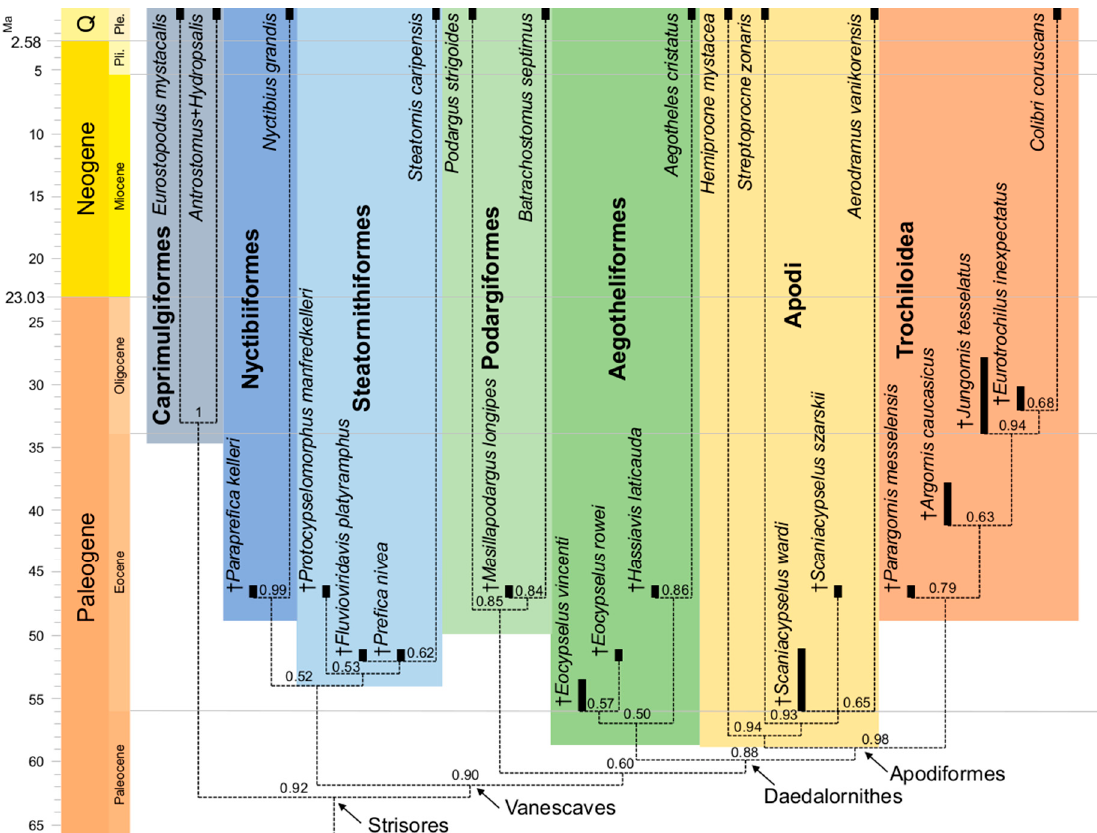
Figure 5. 50% majority-rule tree resulting from Analysis 4 (run with combined morphological and molecular data) scaled to geologic time. For MrBayes output tree showing inferred branch lengths, see Figure S1. Dagger (†) indicates extinct taxa. Age ranges for fossil taxa include stratigraphic uncertainty and are based on Mayr [30,39] and Ksepka and Clarke [54]. Timing of divergence between Eurostopodus and other caprimulgids is based on Prum et al. [3]. The ages of other divergences represent minimum estimates constrained by the ages of fossil taxa, though a Paleocene origin of crown-Strisores has been favored by several recent studies [3,44,75]. Numbers on nodes represent Bayesian posterior probabilities.